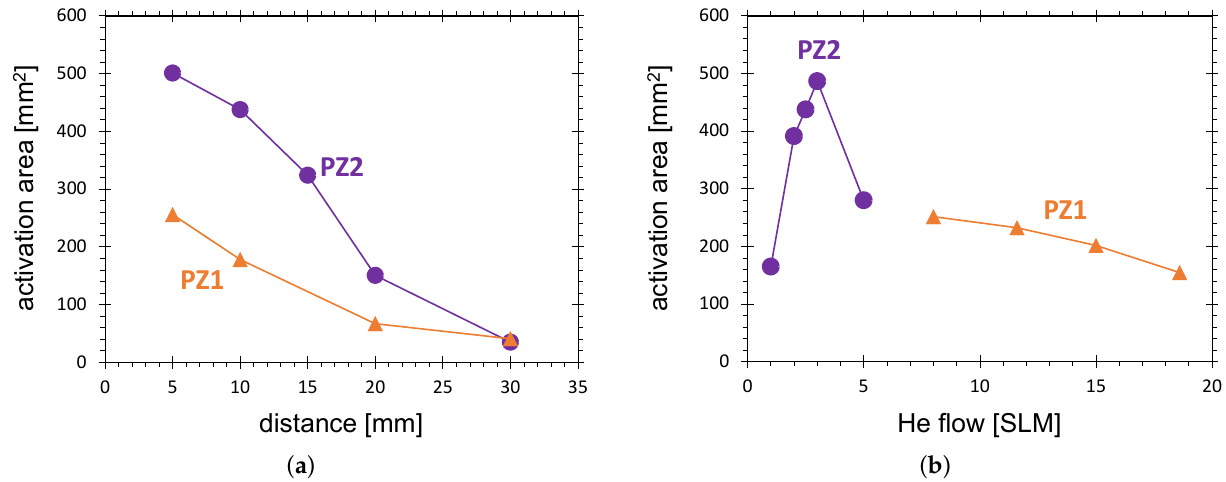
Figure 23. Comparison of the piezobrush ® PZ2 and piezobrush ® PZ1 activation area after 10 s treatment with helium plasma, visualized on HDPE with test ink gauged for 58 mJ/m 2 , as a function of ( a ) distance between the PCPT and the substrate (gas flow of the piezobrush ® PZ1 and piezobrush ® PZ2 is 10 SLM and 2.5 SLM, respectively), and ( b ) helium flow (distance of the piezobrush ® PZ1 and piezobrush ® PZ2 from the substrate is 5.5 mm). The piezobrush ® PZ1 and piezobrush ® PZ2 were operated with 20 W and 8.3 W input power,